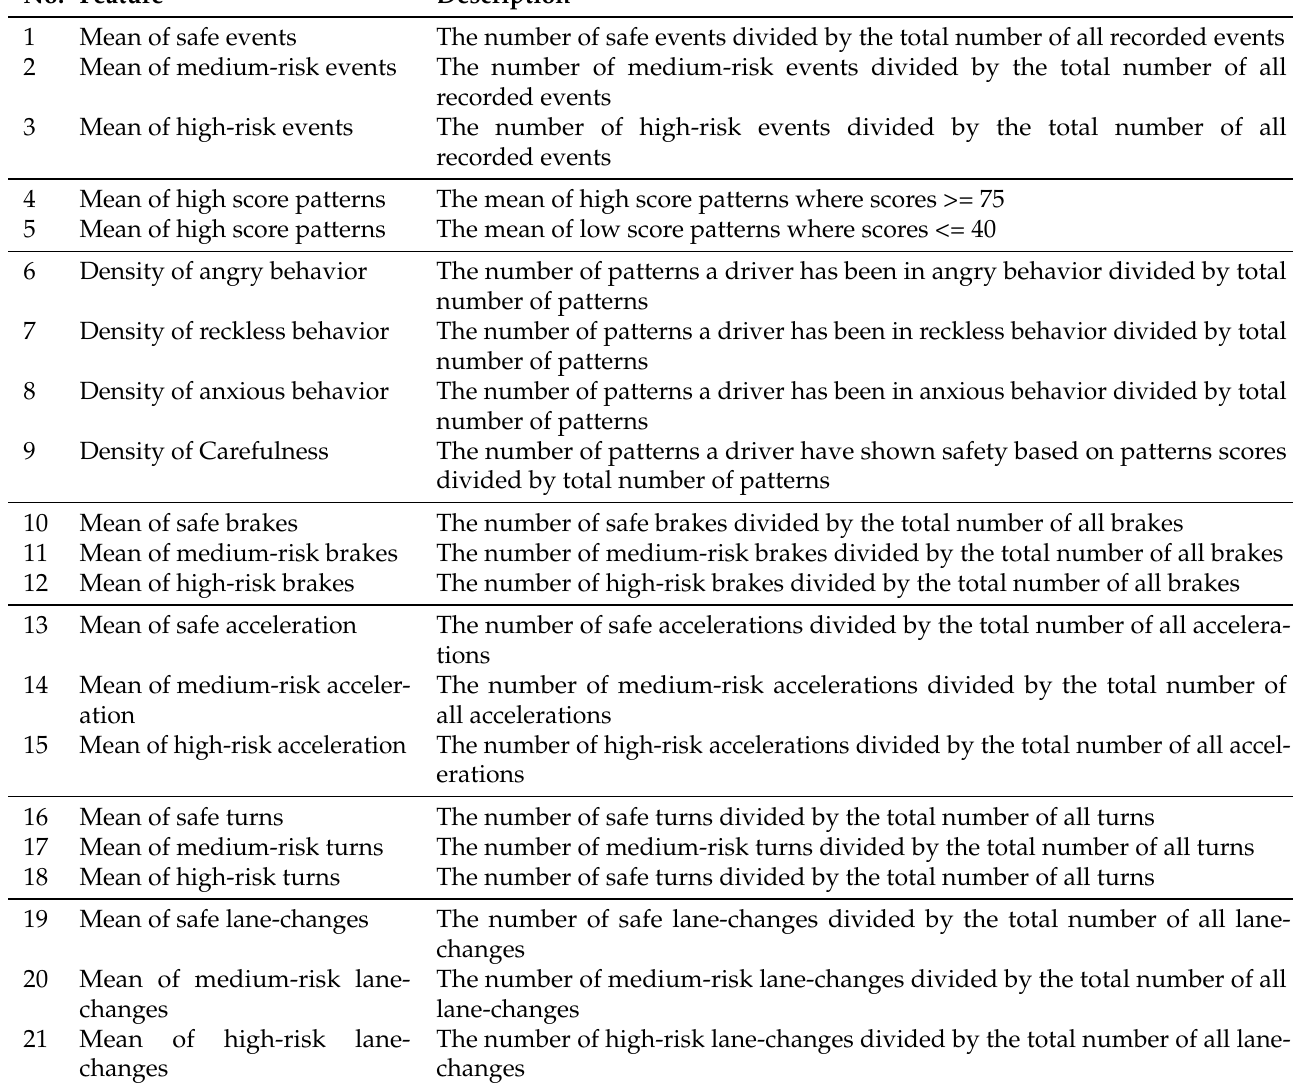
Table 5. Personality groups K-means